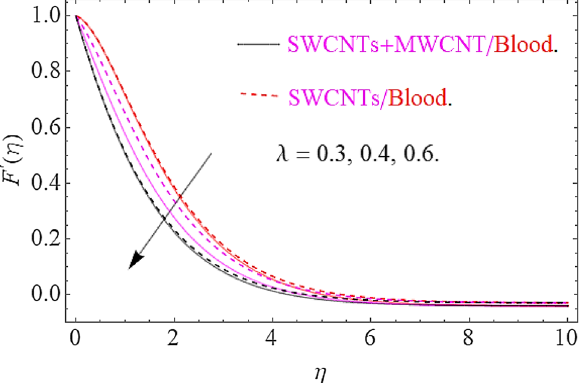
Figure 4. Impact of (cid:31) on F ′ (η) .